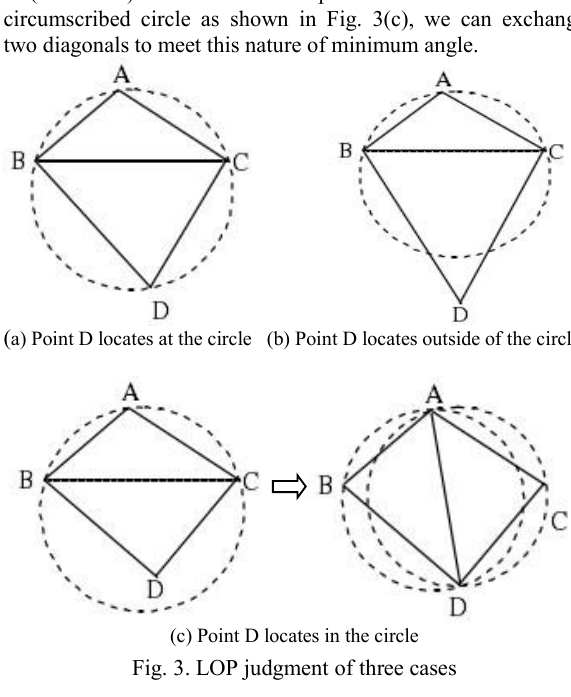
(e) insert the n-th point by iteration (f) Delaunay triangulation network Fig. 2. Incremental insertion algorithm schematic diagram (2) LOP (Local Optimization Procedure): LOP is based on the